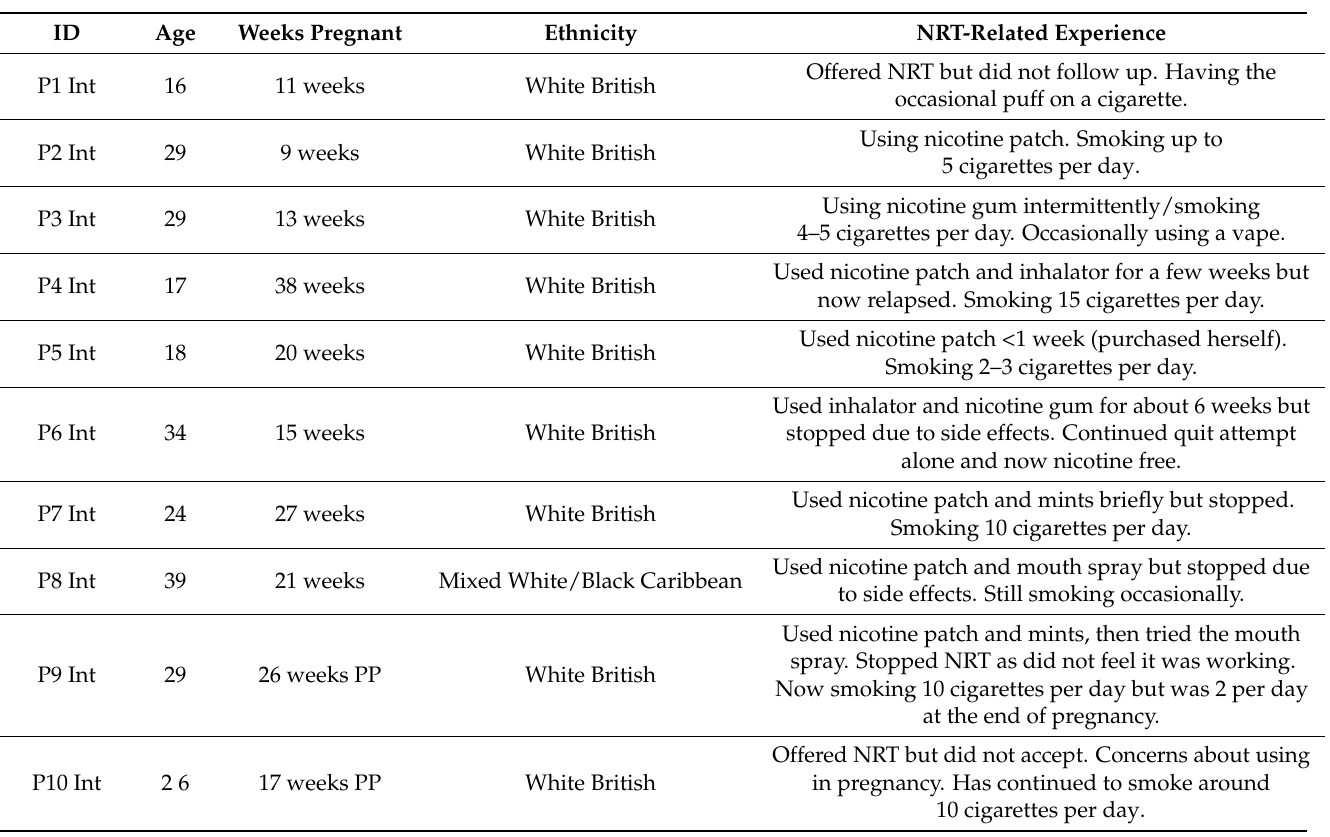
Table 2. Characteristics of pregnant and postpartum (PP)